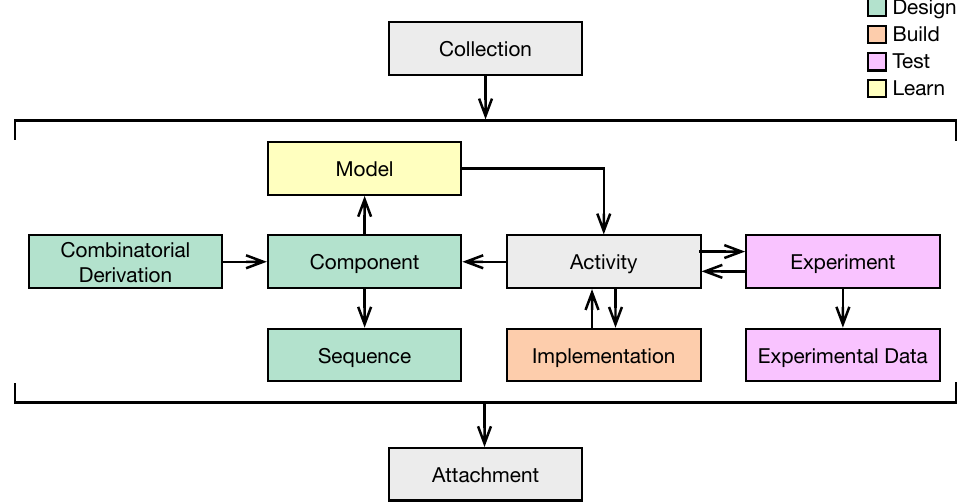
Figure 3: Main classes of information represented by the SBOL 3 standard, and their relationships. Green boxes represent design classes, orange boxes represent build classes, purple boxes represent test classes, yellow boxes represent learn classes, and the gray boxes represent additional utility classes. Each of these classes will be described in more detail